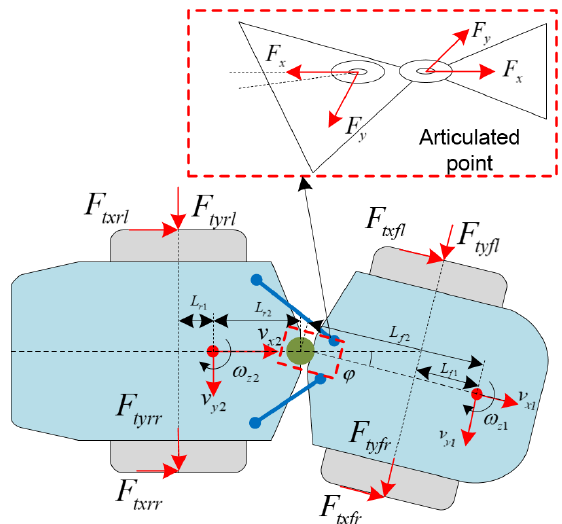
Figure 2. Typical structure of ASV.